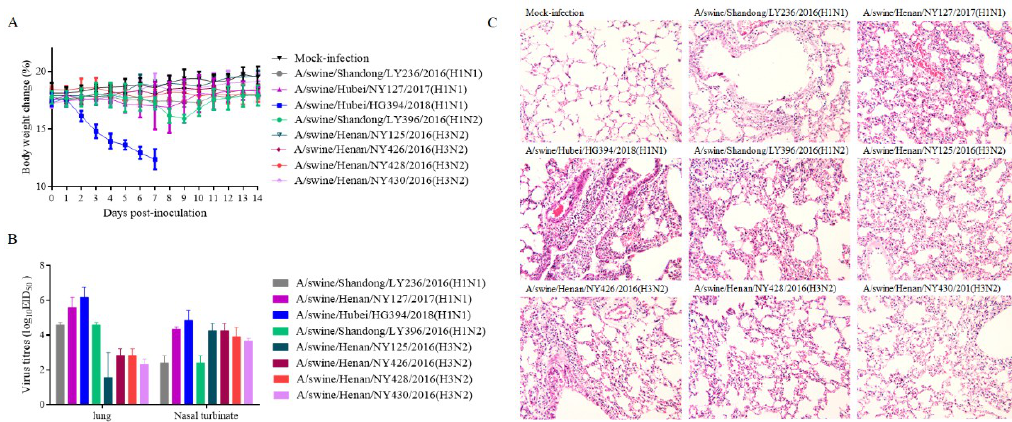
Figure 2. Pathogenicity of the isolated IAV-S in mice. ( A ) Mouse body weights were monitored daily for 14 days. The values represent the average scores of overall body weight loss, compared with the initial body weight ± standard deviation (SD). ( B ) Viral titers in the lungs and nasal turbinate of the infected mice ( n = 3) at 3 DPI. ( C ) Histopathology analysis of lungs. Lungs of the infected mice were fixed with formalin, embedded in paraffin, and stained with hematoxylin and eosin and observed under a microscope with 200× magnification.